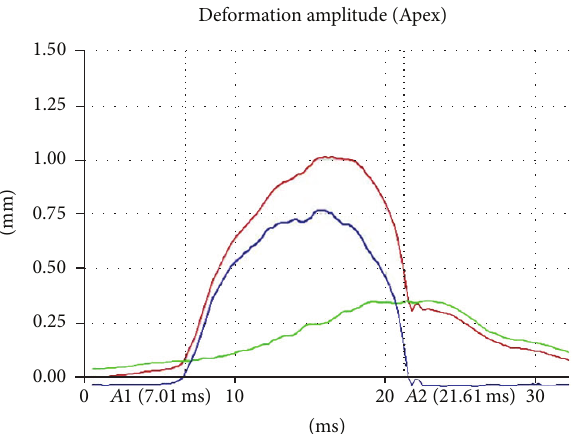
Figure 1: Deformation/deflection/eye movement diagram. Blue line: deflection; red line: deformation; green line: whole eye move-